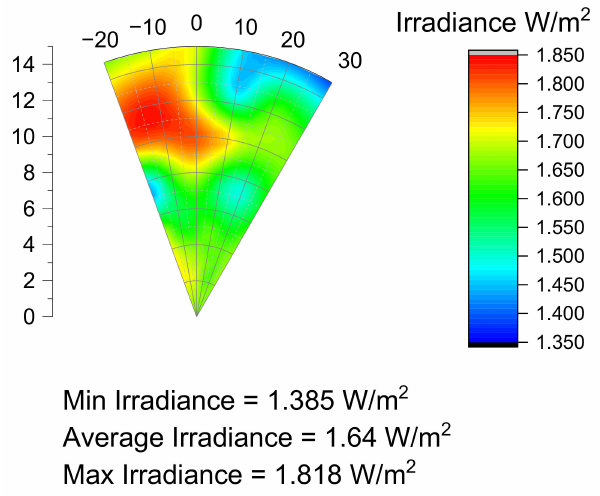
Figure 12. Measured uniformity on the surface of a 250 mm sphere